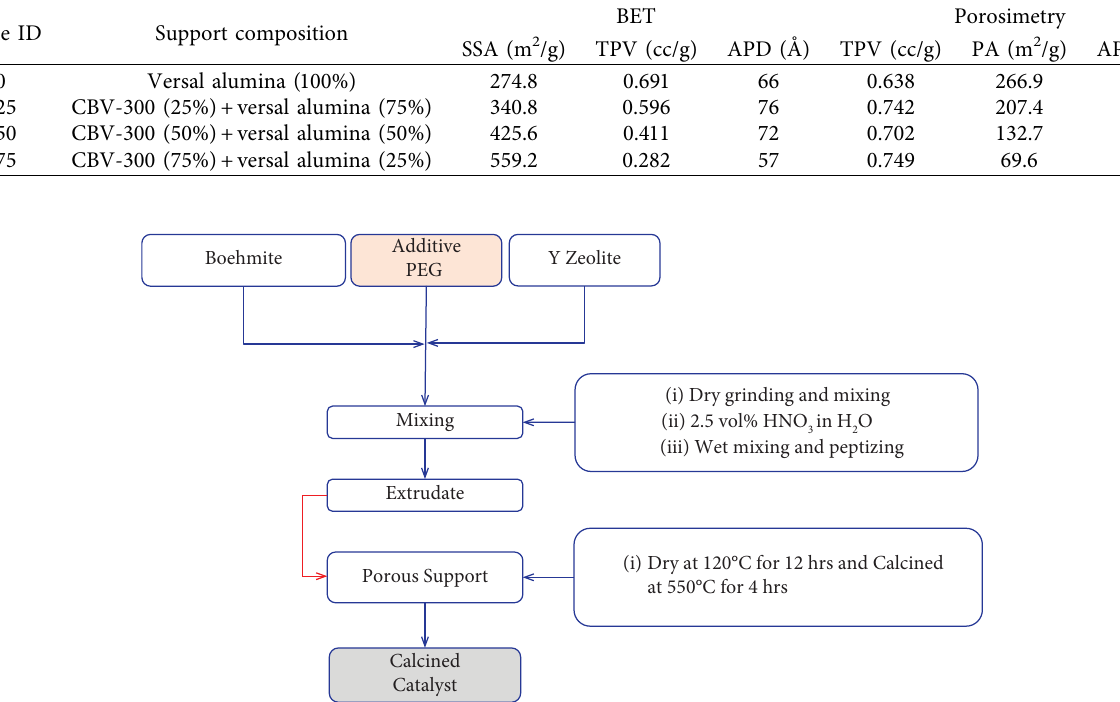
Figure 1: Flow diagram of the catalyst preparation and its treatment conditions.